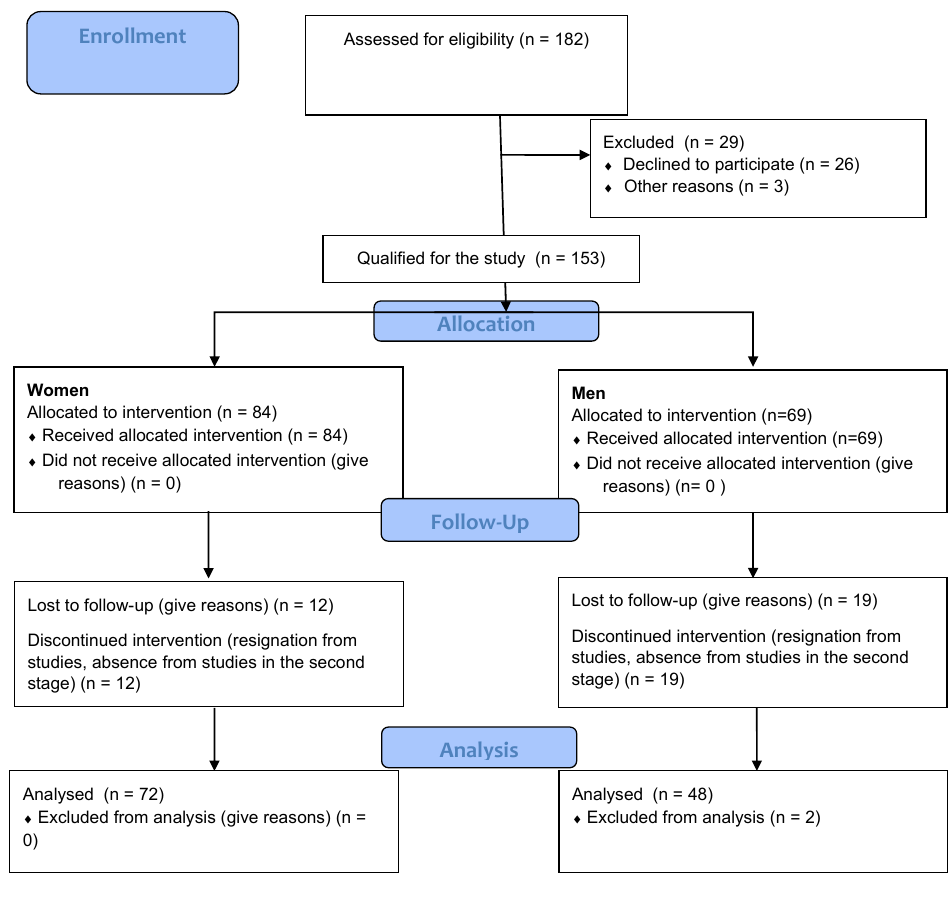
Figure 1. CONSORT diagram.